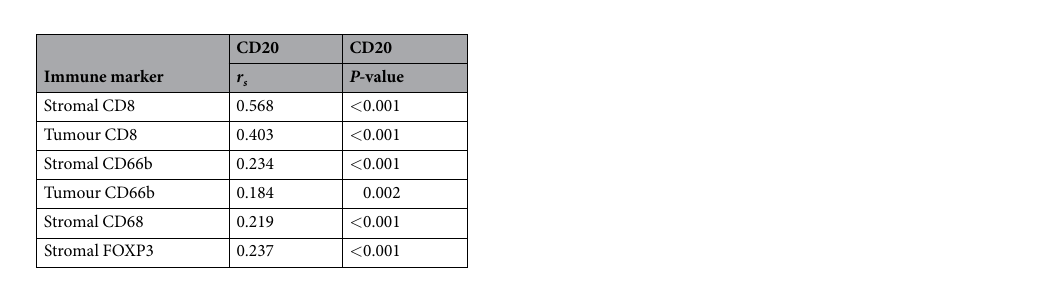
Table 2. The correlation of infiltration of CD20 positive cells in the stromal compartment to infiltration of other immune cell markers.